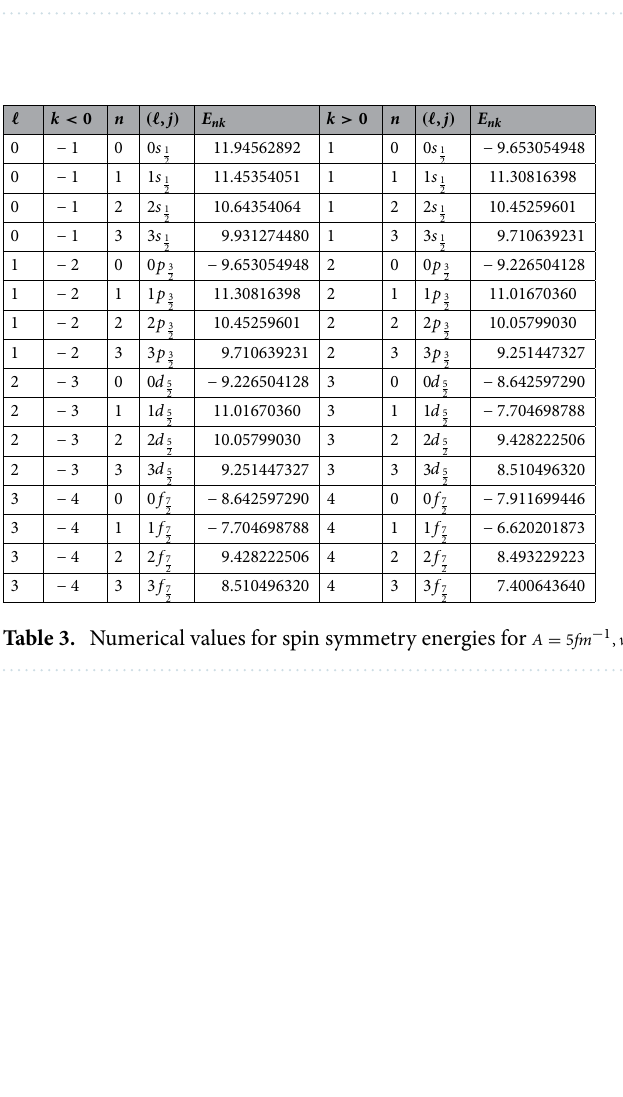
0.2, M 10 fm − 1 , ( (cid:31) = =